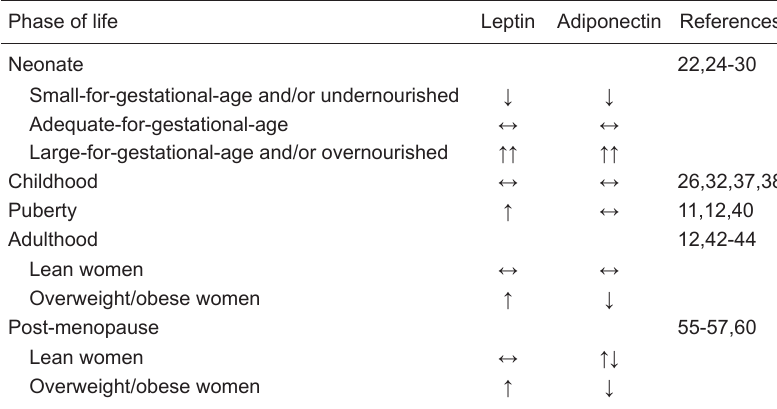
Table 1. Serum leptin and adiponectin concentrations during the female life